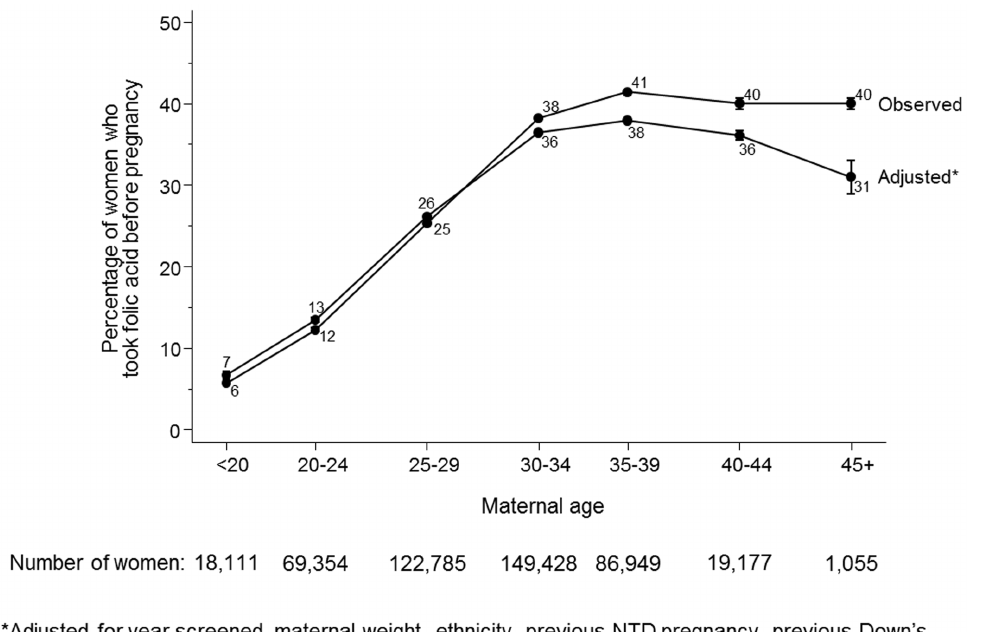
Figure 3. Observed and adjusted* percentage of women taking folic acid supplements before pregnancy according to maternal age.